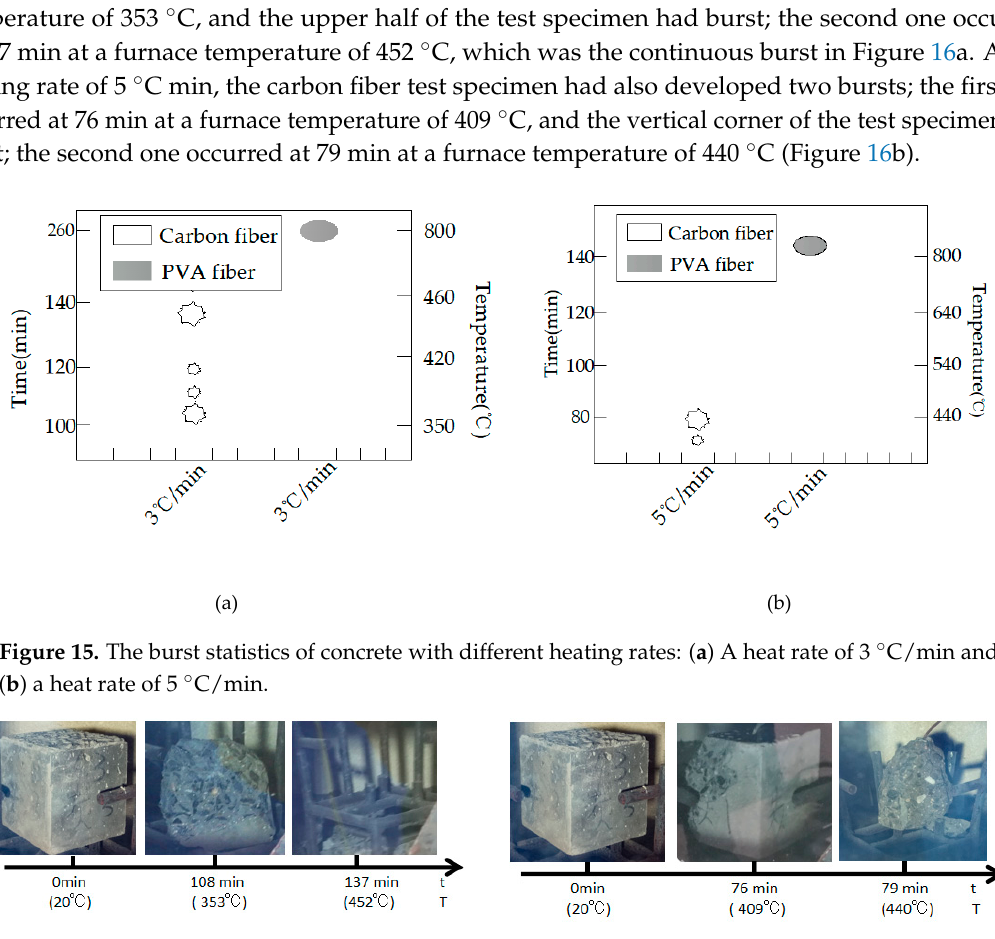
Figure 16. The explosion process of the carbon fiber specimens with different heat rates: ( a ) a heat rate of 3 °C/min and ( b ) a heat rate of 5 °C/min.